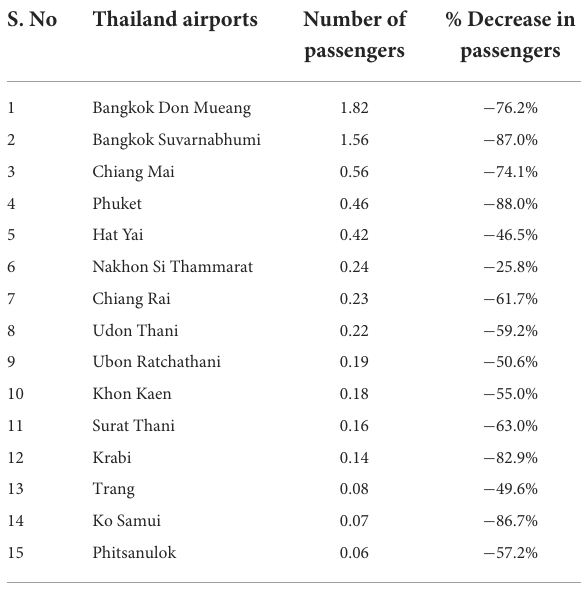
TABLE 1 Statistics of air service users in the first quarter of